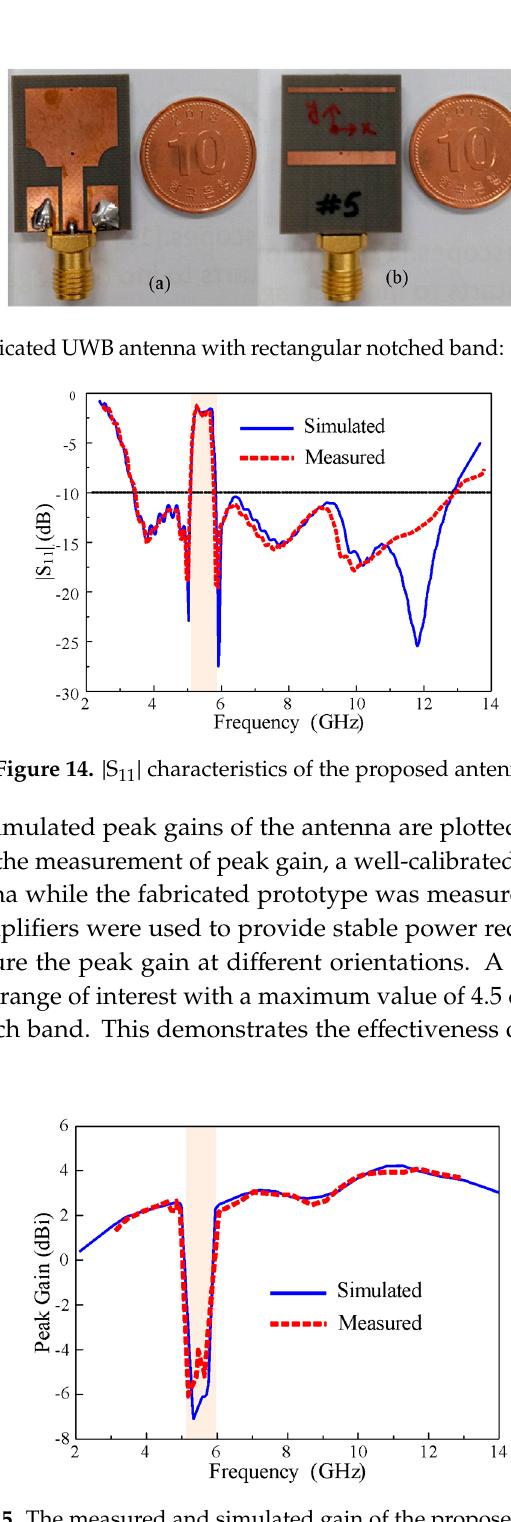
Figure 16. Simulated measure radiation pattern in E-and H-plane radiation pattern at 3, 7, and 10 GHz.